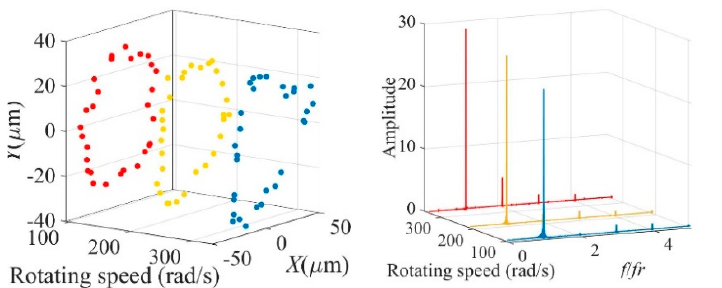
Figure 7. System response at different speeds when the oil pressure is 0.2 MPa.